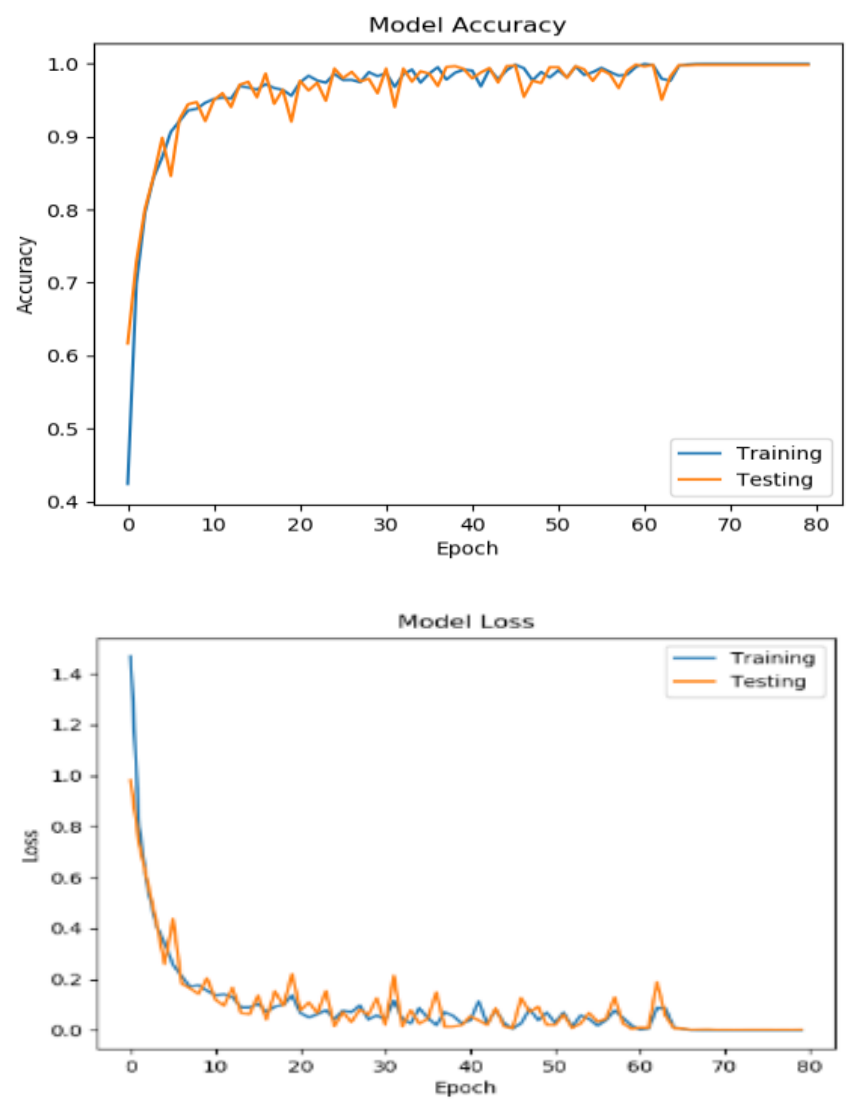
Figure 8. Training and testing accuracy and loss vs. epochs for the proposed model.